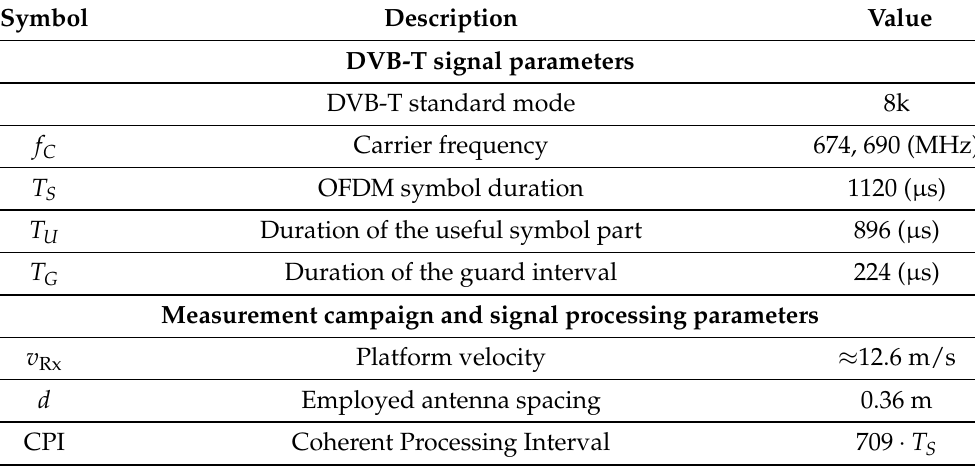
Table 1. List of parameters of the analyzed DVB-T signal, as well as the parameters of the measure- ment campaign and signal processing.